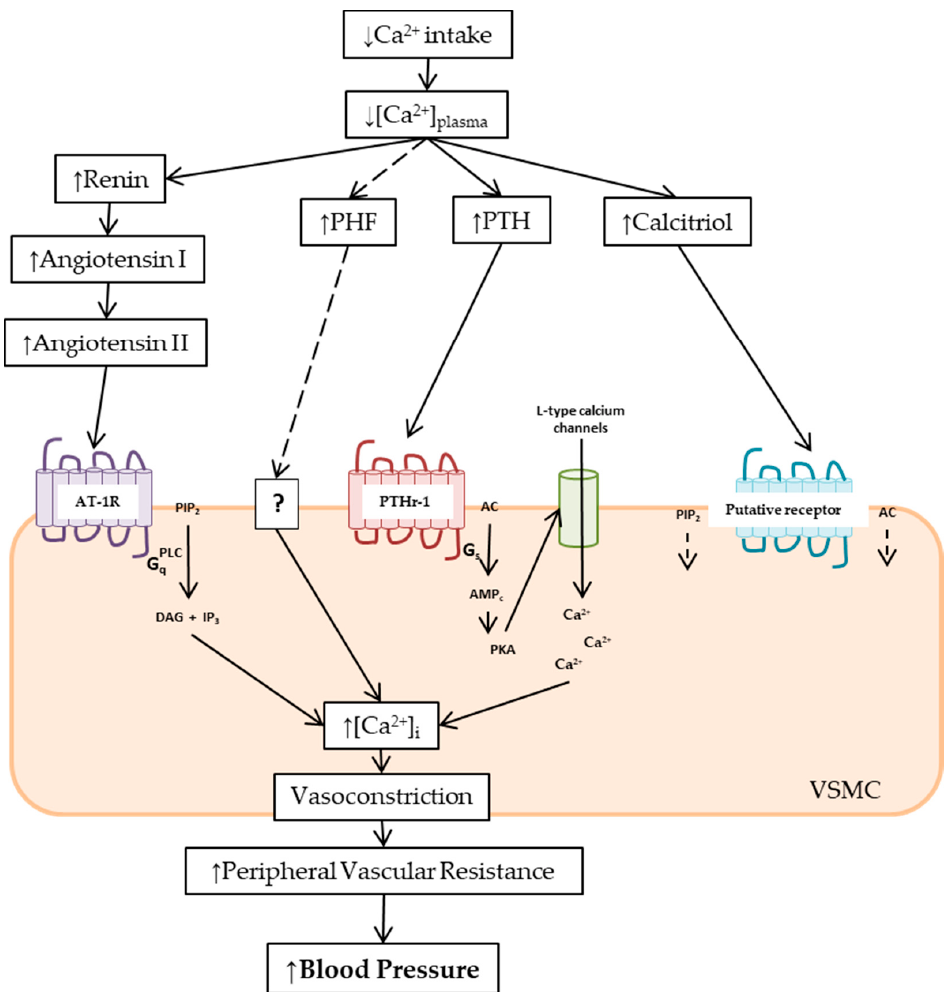
Figure 1. Scheme of the mechanisms involved in the rise of blood pressure in low calcium intake by an increase in peripheral vascular resistance. Low calcium intake decreases plasmatic calcium concentration ([Ca 2+ ] plasma ), stimulating the release of parathyroid hormone (PTH) and parathyroid hypertensive factor (PHF), the synthesis of calcitriol, and the activation of the renin–angiotensin– aldosterone system (RAAS). In vascular smooth muscle cells (VSMC), angiotensin II via the angiotensin II type I receptor (AT1R)/Gq/phospholipase C (PLC)/inositol trisphosphate (IP3) pathway, PTH via PTHr-1/Gs/3 ′ ,5 ′ -cyclic adenosine monophosphate (cAMP)/protein kinase A (PKA), and calcitriol via adenylate cyclase (AC)/cAMP/PKA and PLC/IP3 signaling pathways increased the intracellular calcium concentration ([Ca 2+ ] i ). The rise of [Ca 2+ ] i leads to vasoconstriction, and hence increases in peripheral vascular resistance and blood pressure. The PHF mechanism of action remains unknown. See text for further details.